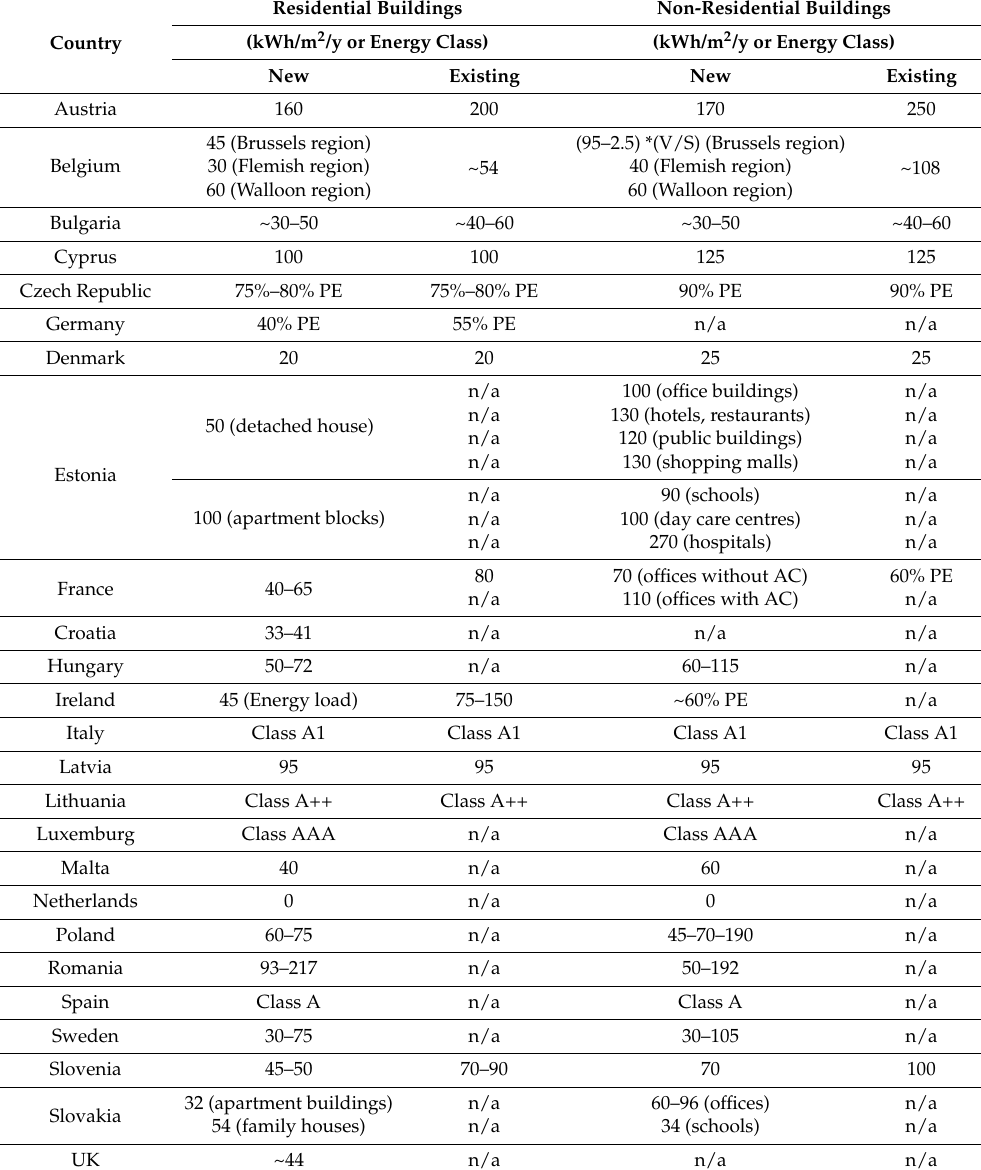
Table 2. Energy requirements defined by EU Member States for NZEB levels. PE: primary energy; and n/a: not